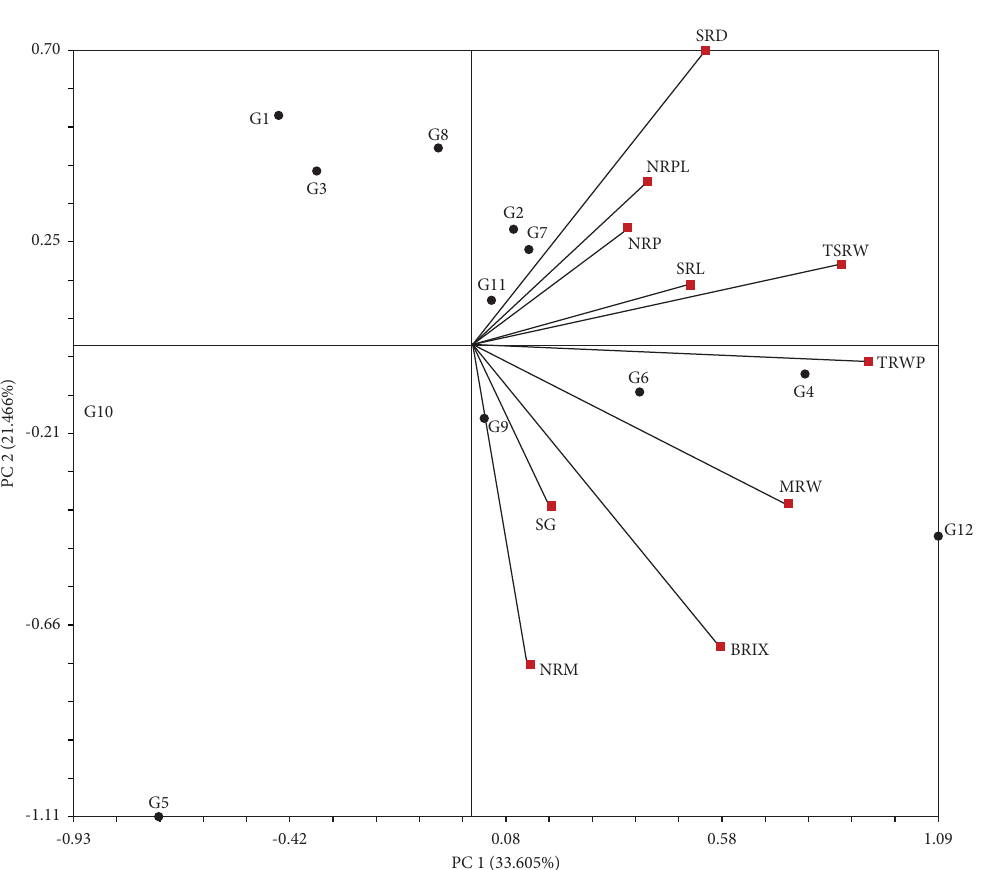
SRL: storage root length, SRD: storage root diameter, NRP: number of roots per plant, TRWP: total root weight per plant, NRM: number of marketable/ commercial roots, MRW: marketable/commercial root weight, NRPL: number of roots per plot, TSRW: total storage Root weight, BRIX: level of sweetness, and SG: specifc gravity.